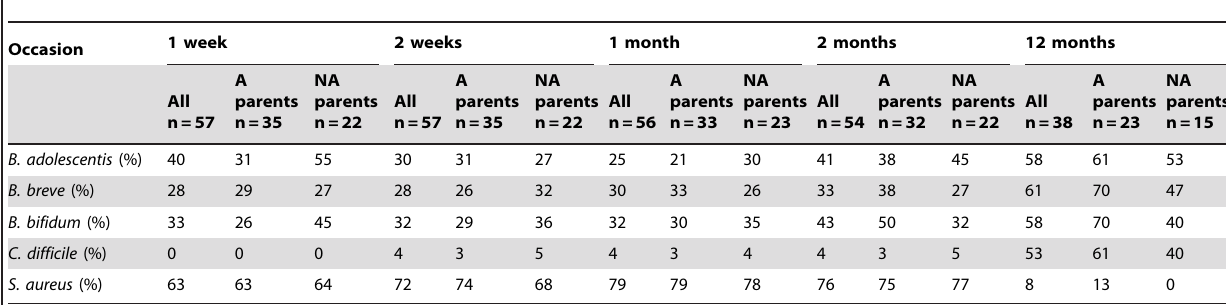
Table 2. Frequencies of bacterial species in infants with allergic and non-allergic parents,